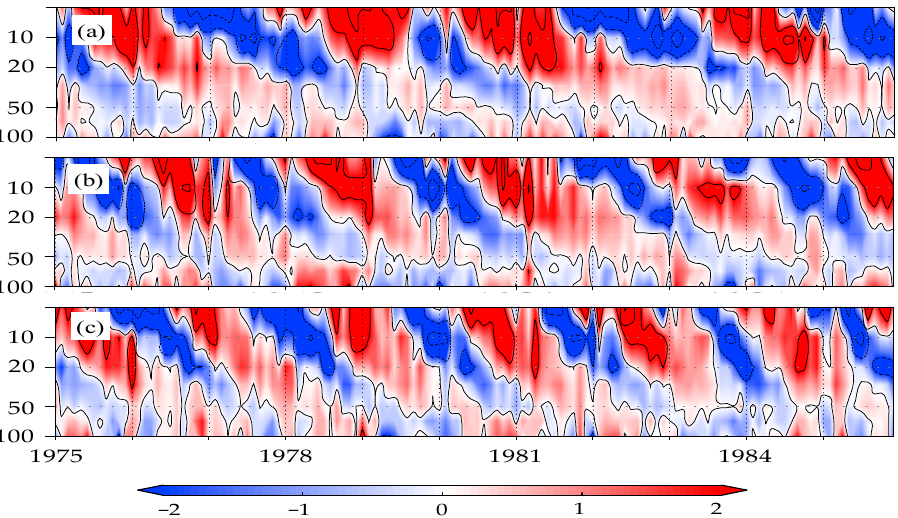
Figure 4. Time–height cross-sections of residual mean vertical velocity anomalies averaged between 10 ◦ S and 10 ◦ N in the tropical stratosphere for the ( a ) P, ( b ) ST, and ( c ) N runs from 1975 to 1985. Units of the color bar scale are in 10 − 4 ms − 1 , and the contours interval is 2 × 10 − 4 ms − 1 . In the observed ozone QBO, there is a phase transition at around 28 km (~18 hPa),